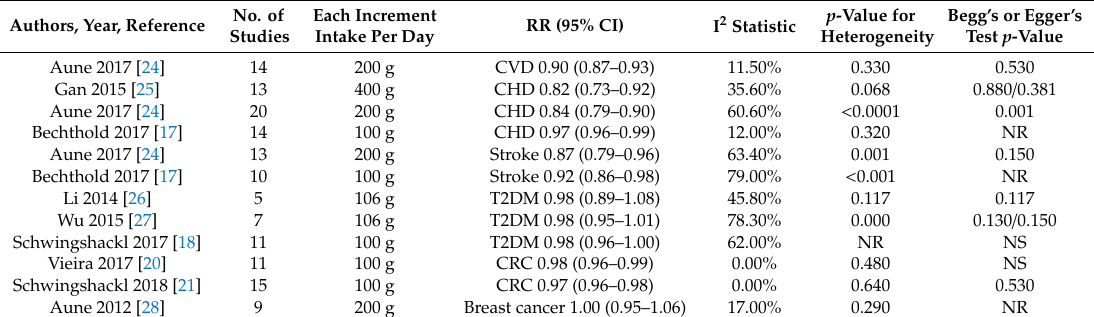
Table 2. Summary of linear dose-response meta-analyses of prospective studies on vegetable intake and CVD, CHD, stroke, T2DM, CRC, breast cancer.